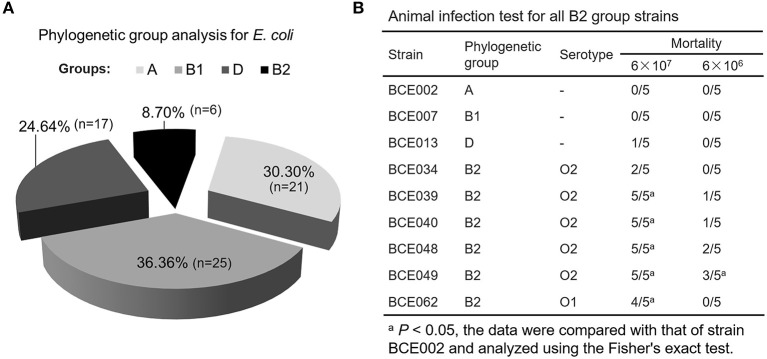
The pathogenicity of phylogenetic group B2 E. coli isolated from the bovine mastitis. (A) The proportion of E. coli isolates belonging to different phylogenetic groups. (B) Animal infection test for all B2 group strains.